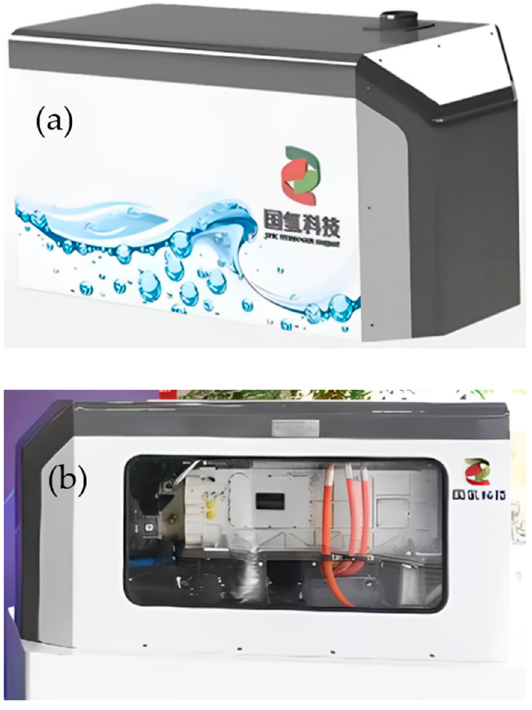
Figure 35. ( a ) Visual design of the FCPS-S120 120 kW marine PEMFC [163]; ( b ) real FCPS-S120 120 kW marine PEMFC [164].